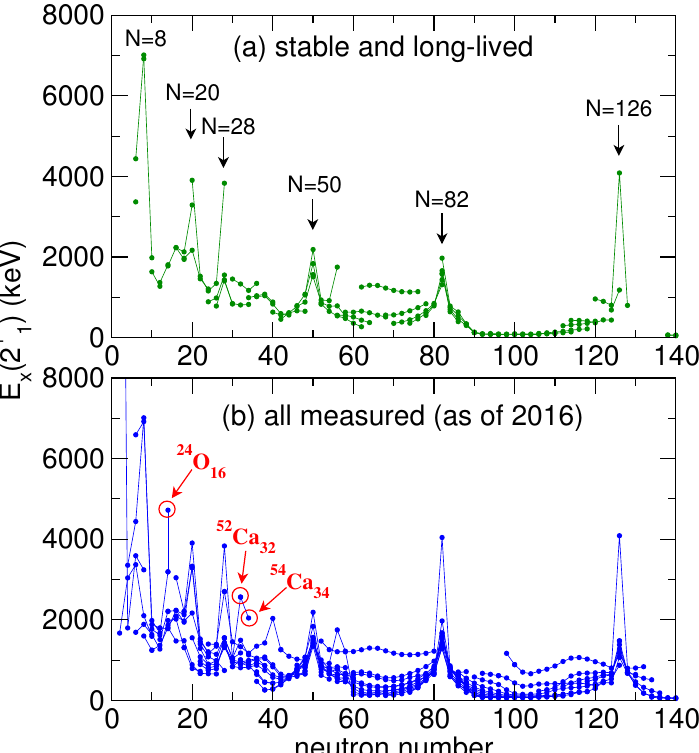
Figure 2. Systematics of the first 2 + excitation energies (E x (2 + and ( b ) all nuclei measured up to 2016, as functions of the neutron number. Peaks in ( a ) are labelled by the neutron number ( N ), while the names of the nuclei are displayed for some new points in ( b ). Taken from Figure 4 of